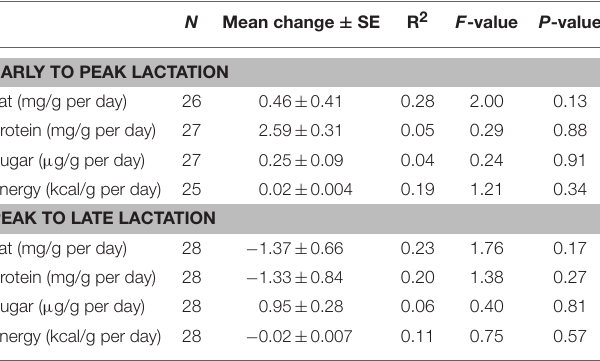
TABLE 2 | General linear models testing effects of maternal characteristics and litter birthdate on changes in milk composition from early to peak lactation and from peak to late